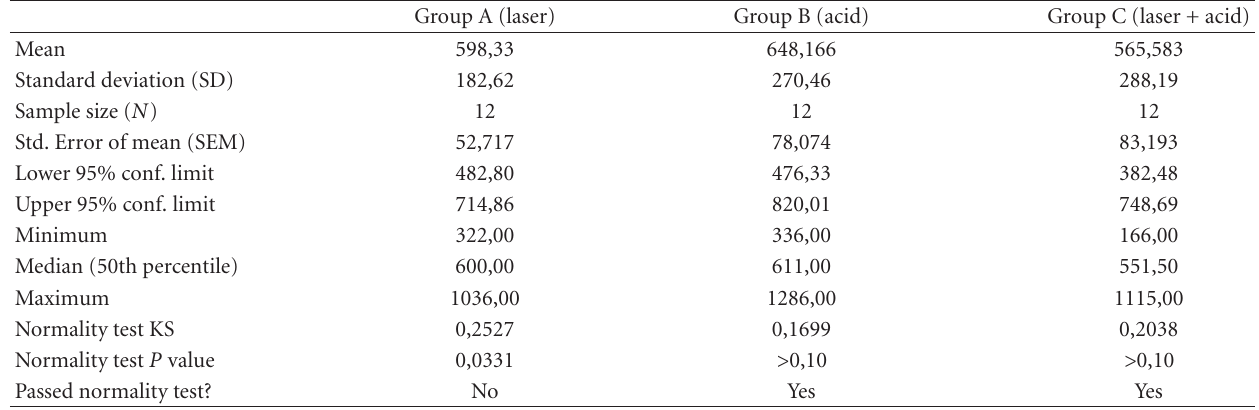
Table 3: Statistical analysis of the forces in the traction test.